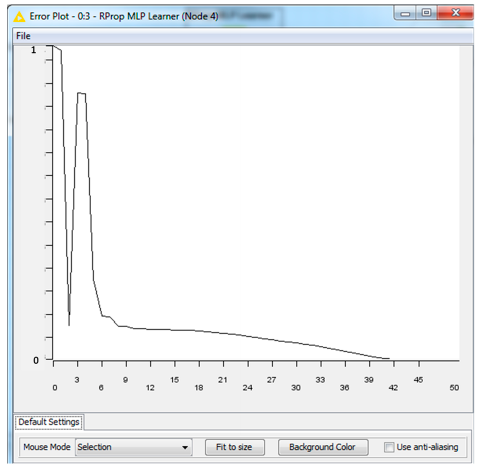
Figure A2. Error trend versus iterations.